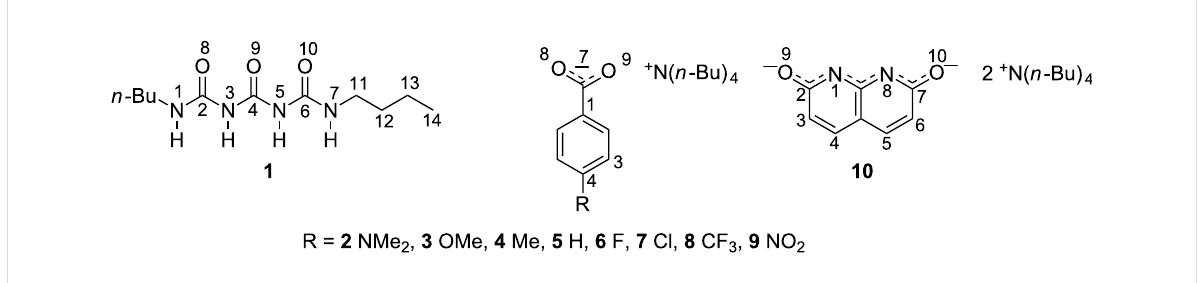
Figure 1: The compounds used in this study and their atom